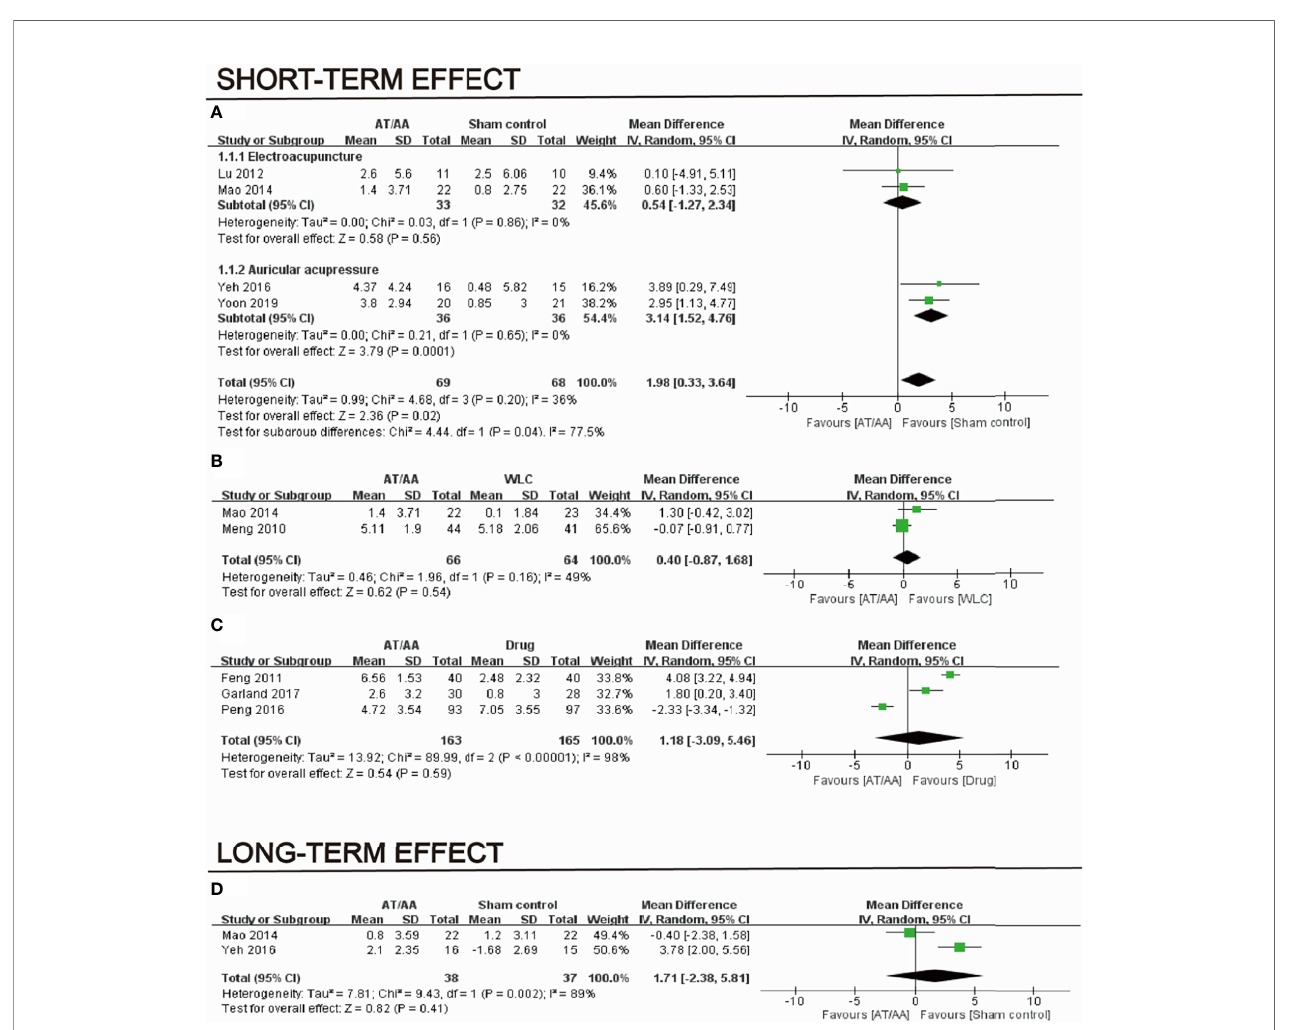
FIGURE 3 | Short-term effect of acupuncture and auricular acupressure groups vs. (A) sham, (B) wait-list, and (C) drug and (D) long-term effect of acupuncture and auricular acupressure groups vs